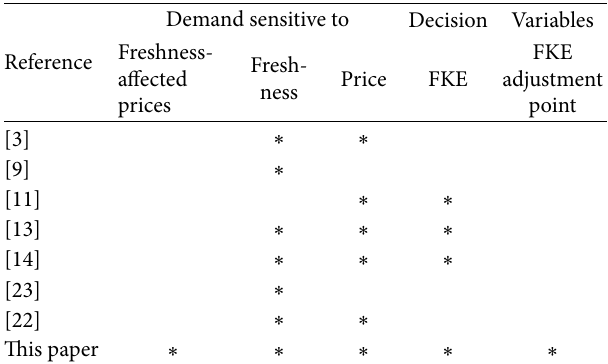
Table 1: This paper versus the FSC literature.